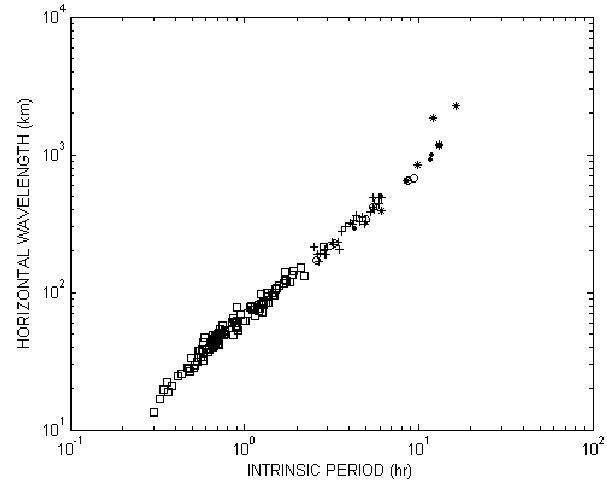
Fig.9 Same as Fig.8 except that the wave packets were from summer data set. Fig. 9. Same as Fig. 8 except that the wave packets were from summer data set.